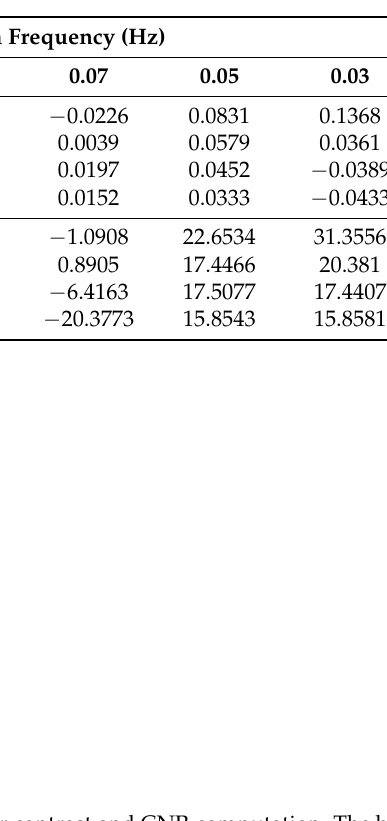
Figure 8. Phase-contrast with four-point method as a function of modulation frequency. Second, to analyze the relationship between phase contrast and CNR, values accord- ing to the modulation frequencies were compared. CNR was the same as a signal to noise ratio (SNR) used in the electrical signal description. The CNR metric is used to differenti- ate the two regions of interest (ROI). CNR is the ratio of the size of the signal (defects) to the size of the noise (sound). Image processing is performed to increase the SNR, and the higher the CNR value, the better the detection ability of the fault. CNR is defined as Equa- tion (14) [37,38].